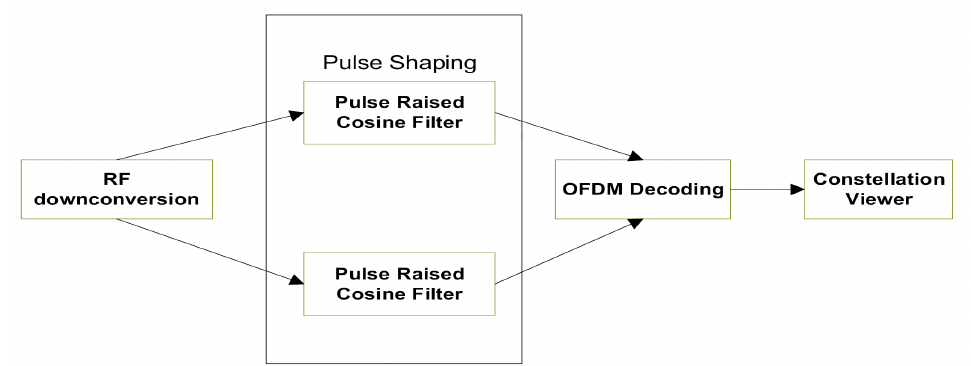
Figure 7. Block representation of the implementation of the OFDM receiver consisting of pulse raised cosine filters, an OFDM decoder and a constellation viewer. RF: Radio